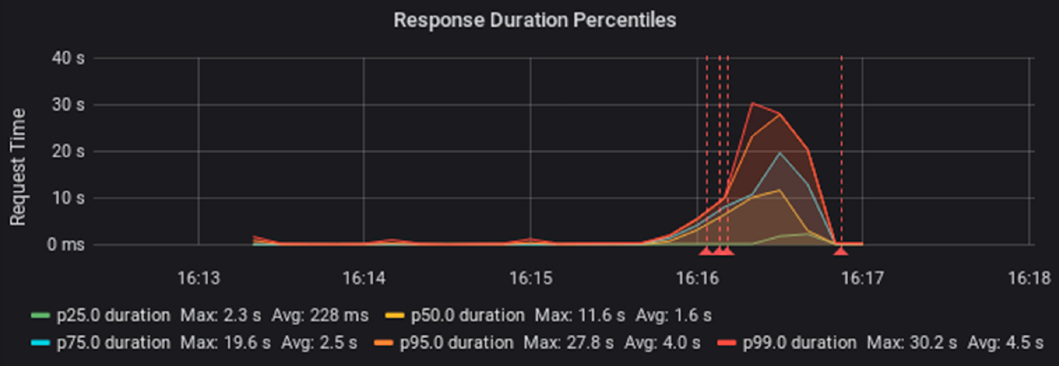
Figure 3. Fedora file system performance begins to degrade at 40 requests per second.